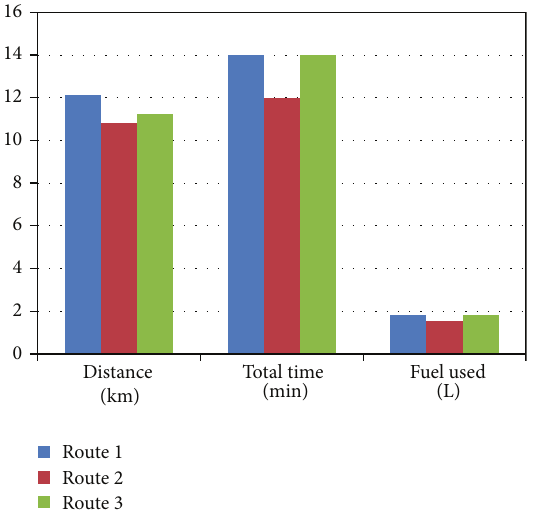
Figure 8: Bar graph for the distance, total travel times, and fuel used in free flow condition.